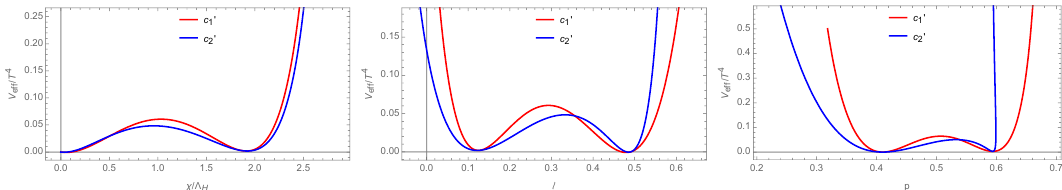
Figure 11 . The potential V e(cid:11) ( L; (cid:31); T ) =T 4 at T c; 5 = (cid:3) H = 3 : 615 as a function of (cid:31) (left), ‘ (center) and p (right) on the two di(cid:11)erent lines c 0 in (3.69) and (3.70).